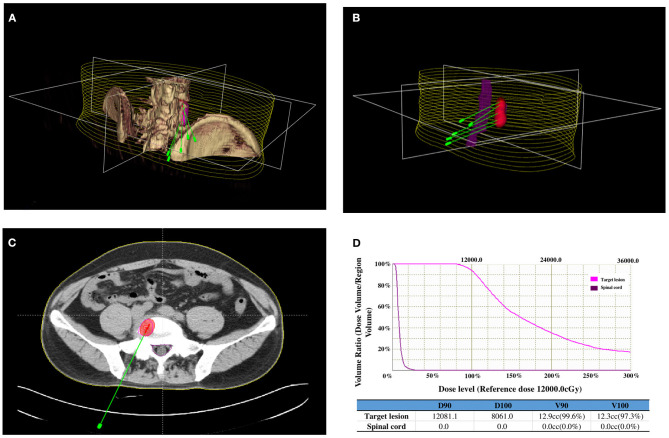
Iodine-125 (125I) brachytherapy treatment plan for bone metastases from breast cancer: (A) CT images of the lesion were reconstructed using a computerized treatment planning system (TPS), and the position of the brachytherapy applicators was calculated. (B) Three-dimensional image showing the relationship between the positions of the applicators, lesions, and spinal cord. (C) Two-dimensional image showing the irradiation dose (red area) of the 125I brachytherapy field, tumor contour (purple line), and spinal cord (green line). (D) Dose-volume histogram indicating the prescribed dose to the lesion and the dose received by the spinal cord.